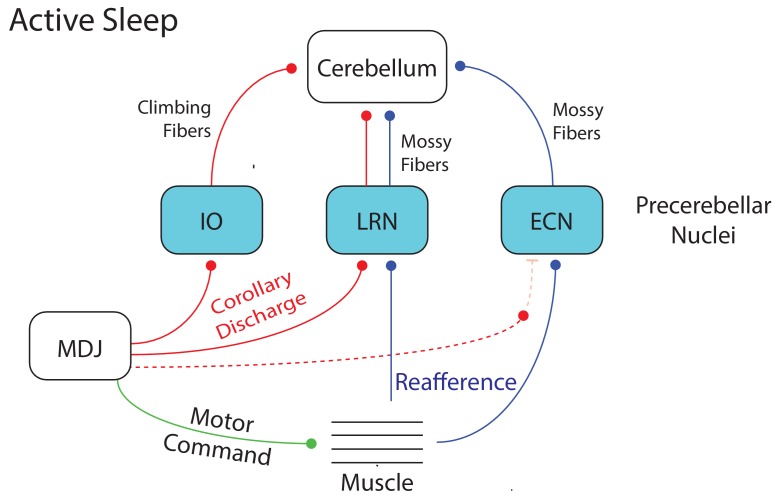
Summary diagram depicting the flow of twitch-related activity in the cerebellar system during active sleep in week-old rats.A motor command from the MDJ to muscle (green line) produces a twitch. At the same time, twitch-related CD (red lines) is conveyed from the MDJ to the cerebellum via the IO and LRN. In addition, twitch-related reafference (blue lines) is conveyed to the cerebellum via the LRN. Also, as shown previously (Tiriac and Blumberg, 2016), reafference to the ECN is not gated during active sleep as it is during wake, thus allowing it to flow unimpeded to the cerebellum. Dotted lines denote hypothesized connections.